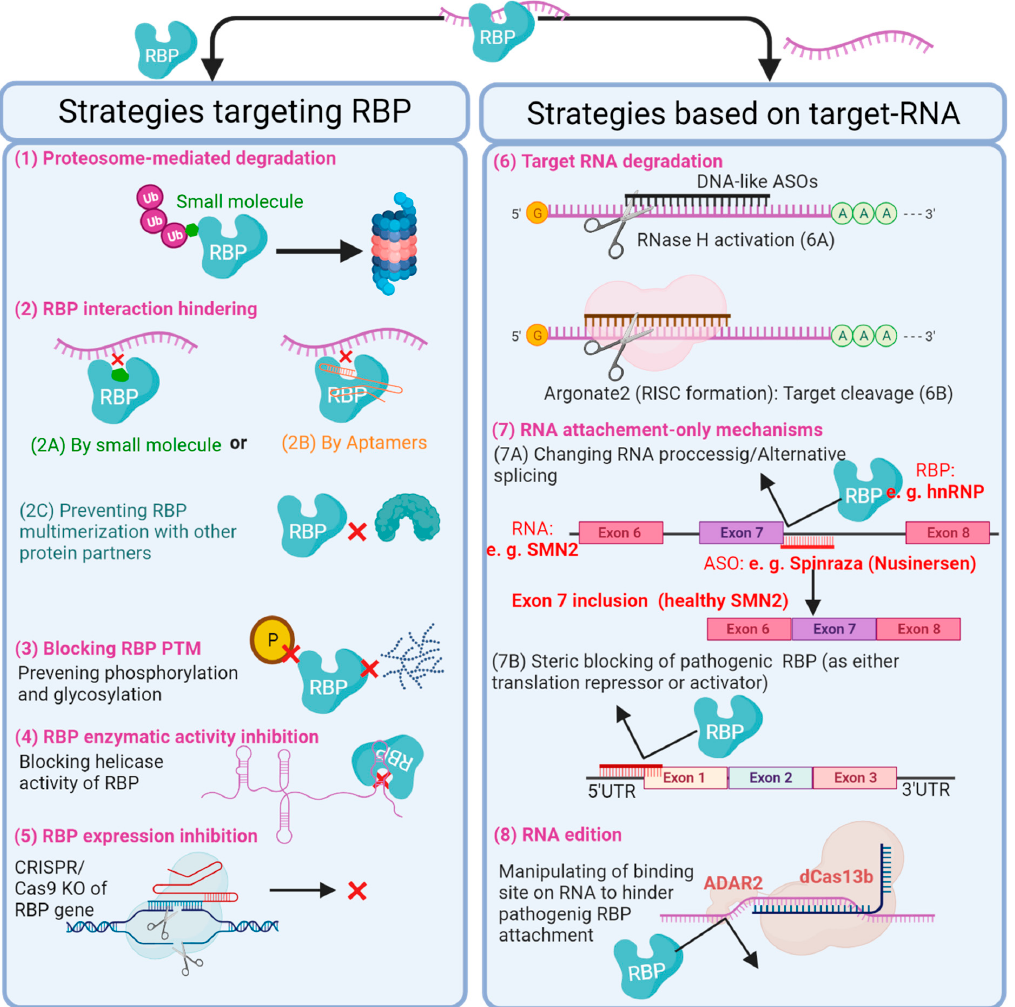
Figure 4. A figure displaying the current potential RNA-binding protein (RBP)-based therapeutic strategies to post-transcriptionally control cellular phenotype, with the aim of restoring or preventing vascular disease states. RBP-based therapeutic strategies either focus on inhibiting the action of the RBP itself or the target RNA. For example, small molecules and Aptamers can be designed to inhibit the action of RBPs either by tagging a specific RBP for degradation by proteasome (1) or by blocking the RBP interaction with either its target RNA or functional protein partner (2A–C). In addition, inactivation of RBPs can be achieved through the prevention of post-translational modifications (3). Another direct therapeutic approach is to block the enzymatic activity of a specific RBP (4) or to knock out its gene by CRISPR/Cas9 (5). RNA-targeting therapeutics, however, could be potentially used to reverse the effects of pathogenic RBPs on mRNA stability, alternative splicing and translation of target RNAs. RNA-based therapeutic tools, such as antisense oligonucleotides (ASOs), siRNAs, miRNAs and CRISPR/Cas, can be exploited to induce degradation of the target RNA independent from RBP (6A and B), block or manipulate interaction between an RBP and its RNA target through RNA occupation only (7) or RNA edition (8). For the latter, an RNA editor such as RNA adenosine deaminase 2 (ADAR2), with the help of the CRISPR/dCas13b system, can introduce point mutations in target RNA; it thereby has the potential to recapitulate a new RBP binding site, rescue a known pathogenic binding site or create a premature stop codon to spoil functionality of target RNA, for example. Within the figure, validated examples are shown in red text. RISC, RNA-induced silencing complex; KO, knockout; PTM, post-translational modifications; ASO, antisense oligonucleotide; SMN2, survival of motor neuron 2